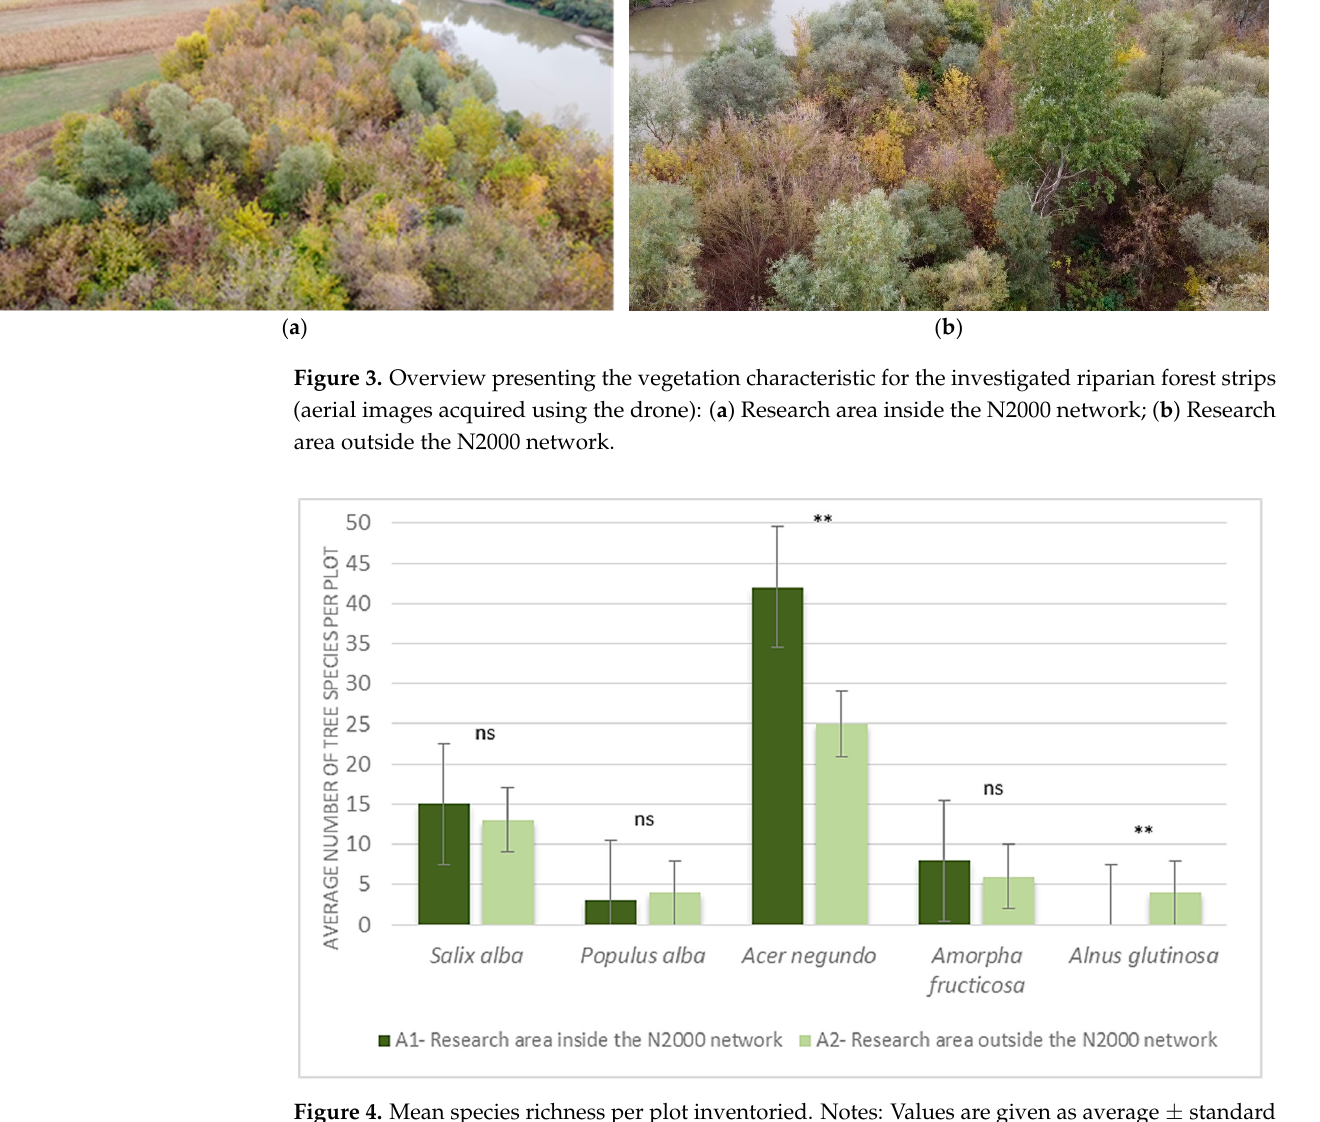
Figure 4. Mean species richness per plot inventoried. Notes: Values are given as average ± standard error. Effects were accepted as statistically significant if p ≤ 0.05, as follows: ns— p > 0.05—not sig- As illustrated in Table 2, the A2 research area showed a lower number of trunks per plot compared to A1, and a higher diversity (highlighted through H ′ index, which scored the highest value in A2). Moreover, A2 included an even population distribution of spe- cies (highlighted by J value, which was 0.76 for A2, compared to 0.68 for A1). Significant difference in Shannon–Wiener ( p < 0.00) and Evenness ( p < 0.01) diversity indices were recorded among the two research areas. Table 2. Diversity indices for the research areas inside and outside the N2000 network. Values are given as average ± standard deviation. Values within the same column followed by a common letter are not significantly different according to t -test (for the mean number of trunks per plot) and Hut- cheson t -test (for the diversity indices).